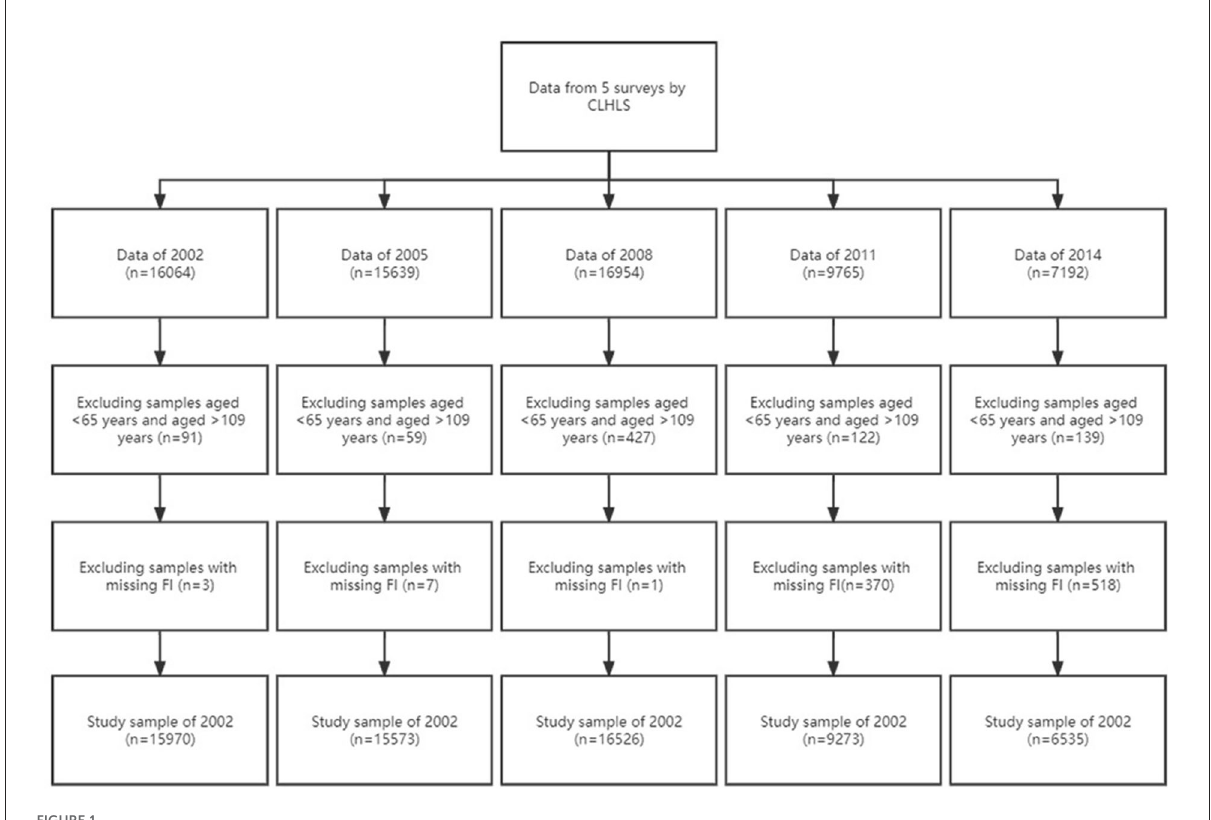
FIGURE1 Flowchart of the study